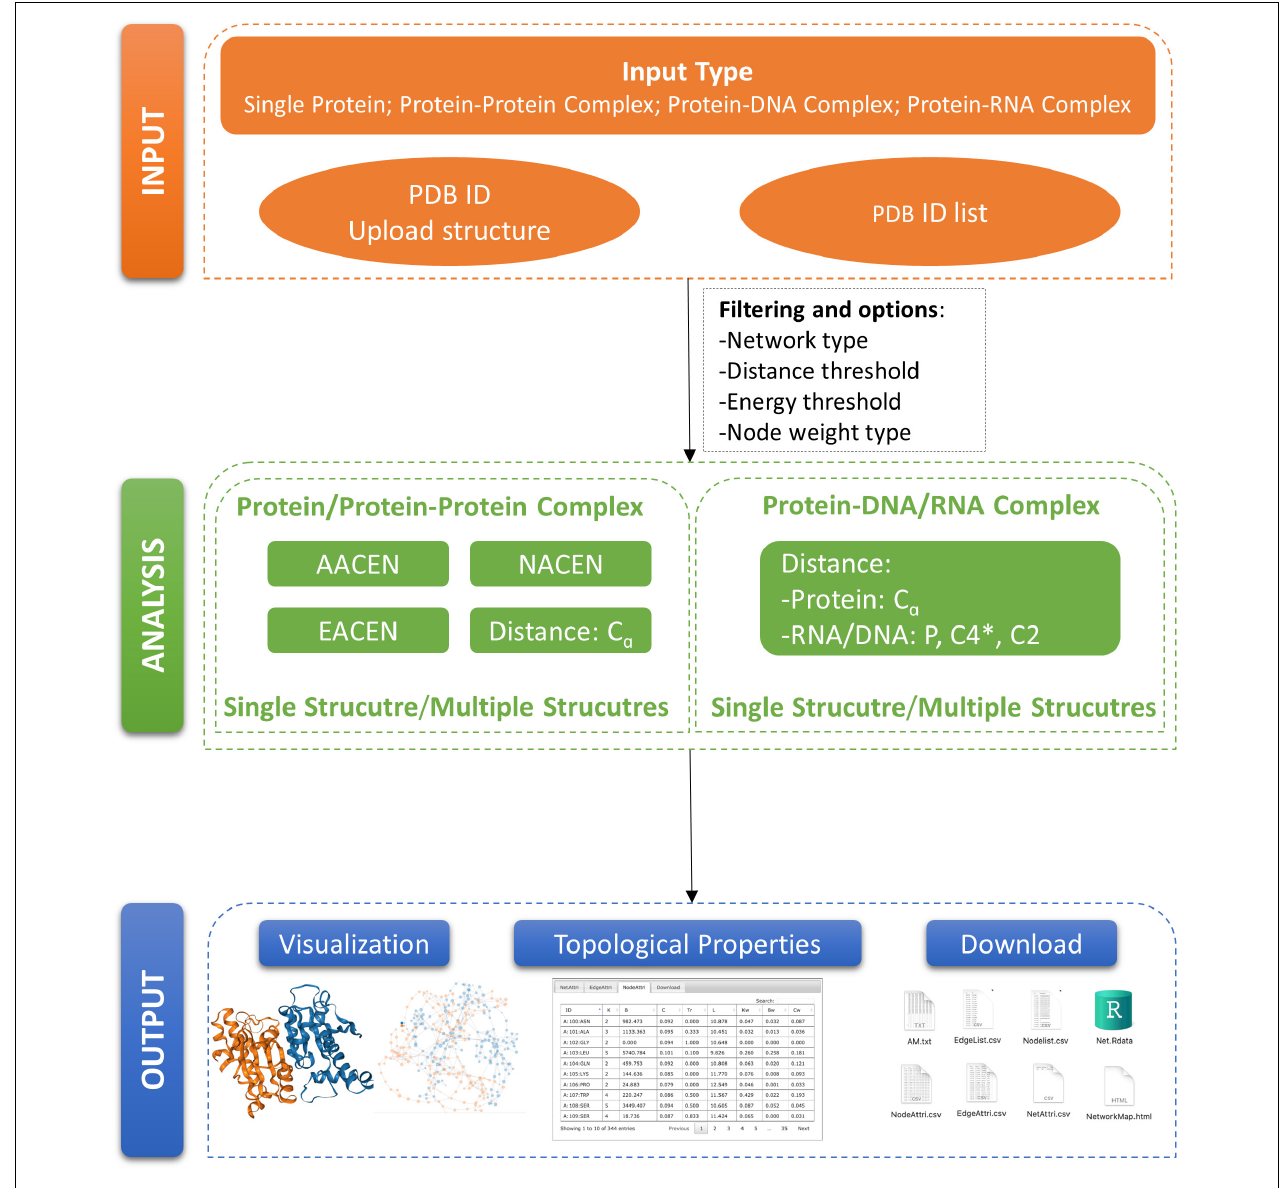
FIGURE 1 | Organization of ANCA (Amino Acids Network Construction and Analysis). A schematic view of ANCA input, analysis, and output is provided here.